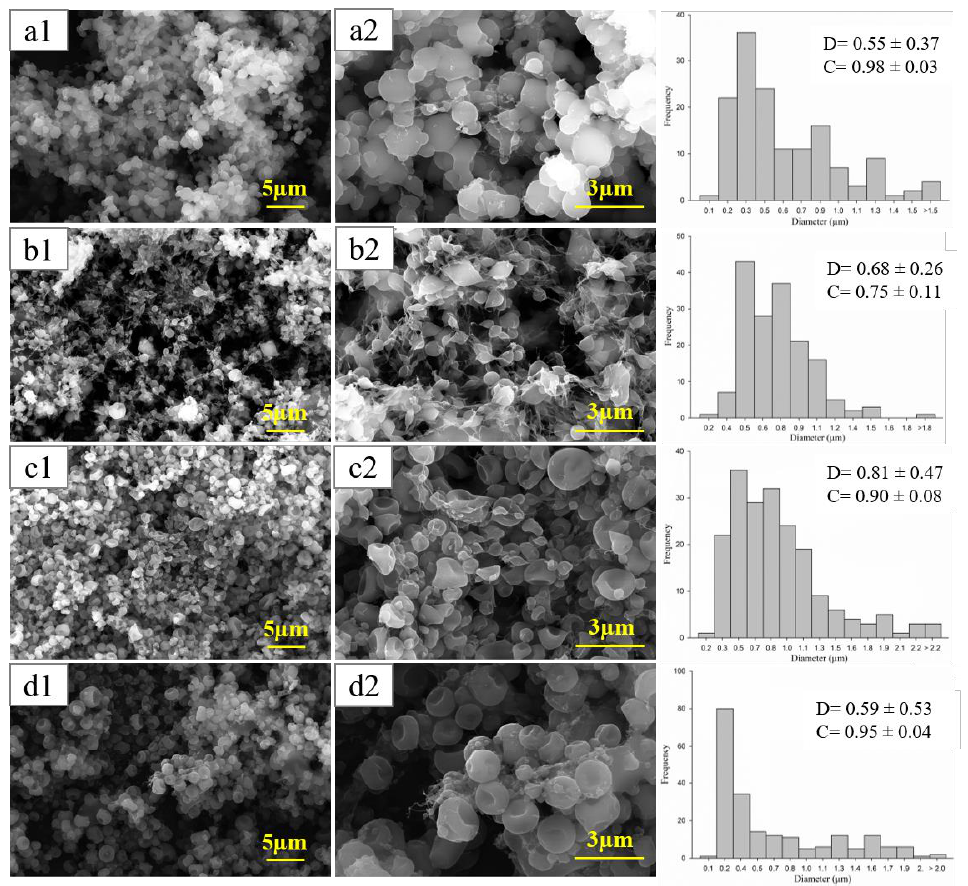
Figure 2. SEM micrographs of the capsules ( a ) G-Bet, ( b )HPMC-Bet, ( c ) G-Bet/HPMC y ( d ) HPMC- Bet/G. SEM images at the left ( 1 ) and right ( 2 ) correspond to 10 kx and 30 kx magnifications, respectively. D is the average diameter ( µ m) and C circularity results.